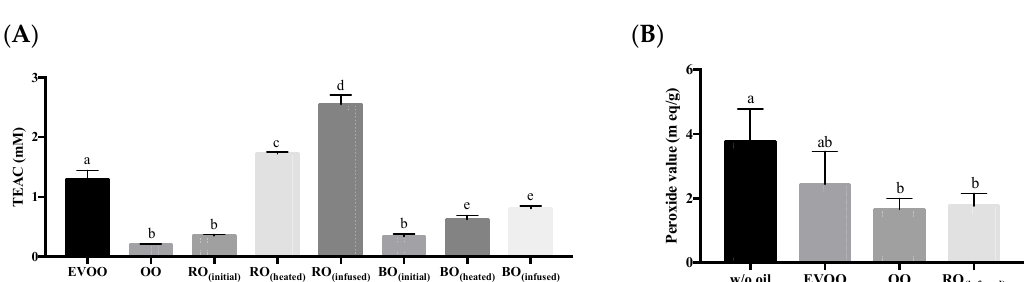
Figure 2. Antioxidant capacity of the cooking oils ( A ) and peroxide value of pan-fried salmon in cooking oils ( B ). Data presented are mean ± S.D. ( n = 3). EVOO: Extra virgin olive oil; OO: Olive oil; RO (infused) : Rosemary-infused oil; BO: Black pepper-infused oil; (initial): Oil collected immediately after addition of condiments; (heated): Oil collected after addition of condiments and heating for 10 min; (infused): Oil collected after addition of condiments, heating for 10 min, and infusion for 1 h. Columns sharing different alphabets are significantly different at least p < 0.05.